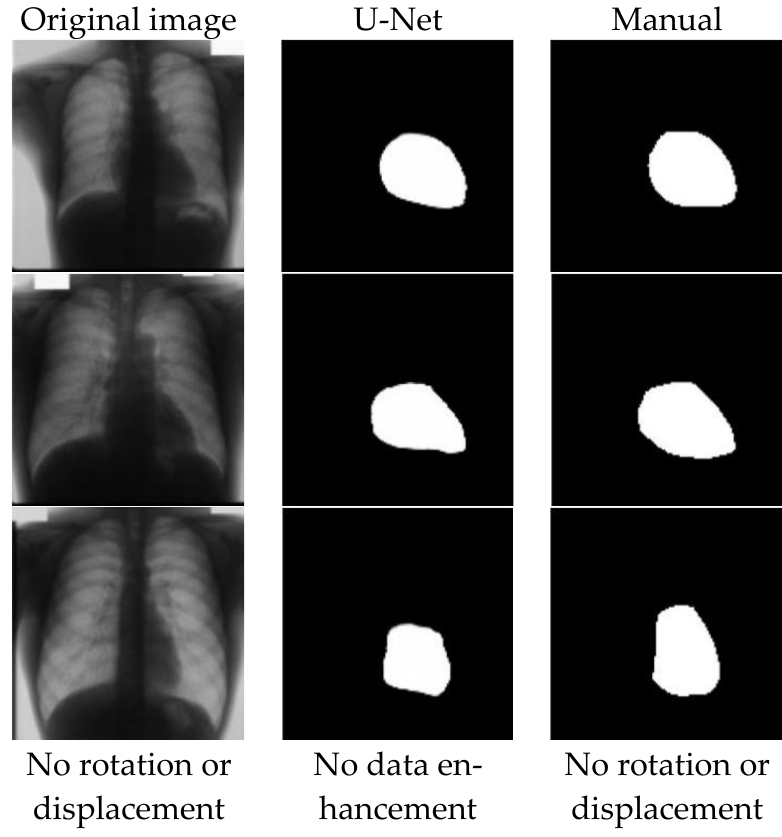
Figure 7. The segmentation results with the original